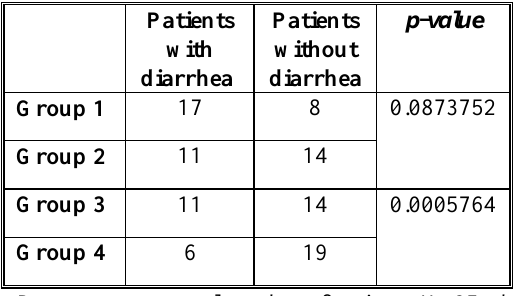
Table 3. Comparison in the incidence of diarrhea for patients after taking ciprofloxacin with levofloxacin and patients taking ciprofloxacin plus lactobacillus with patient taking levofloxacin plus